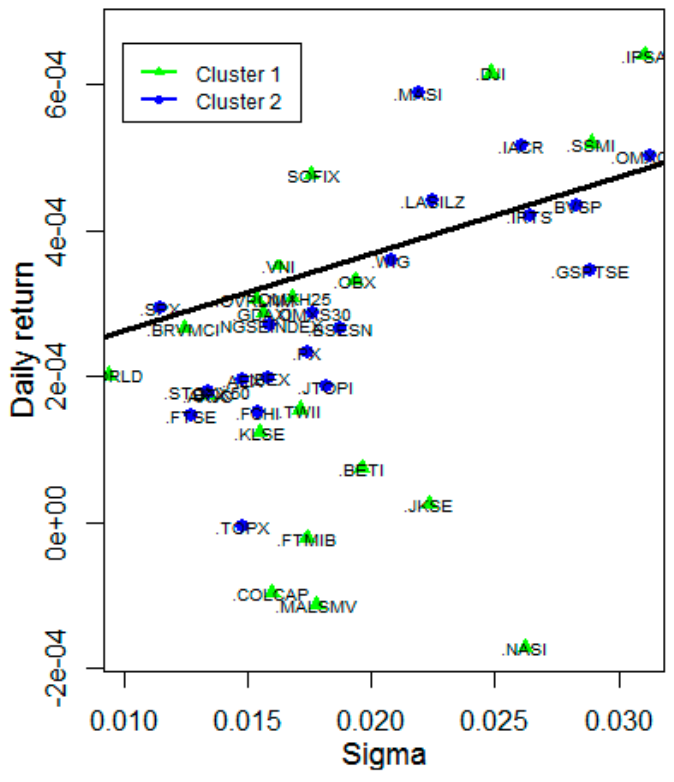
Figure 9. Two Gaussian-kernel based normalized modularity clusters (part of the total graph).